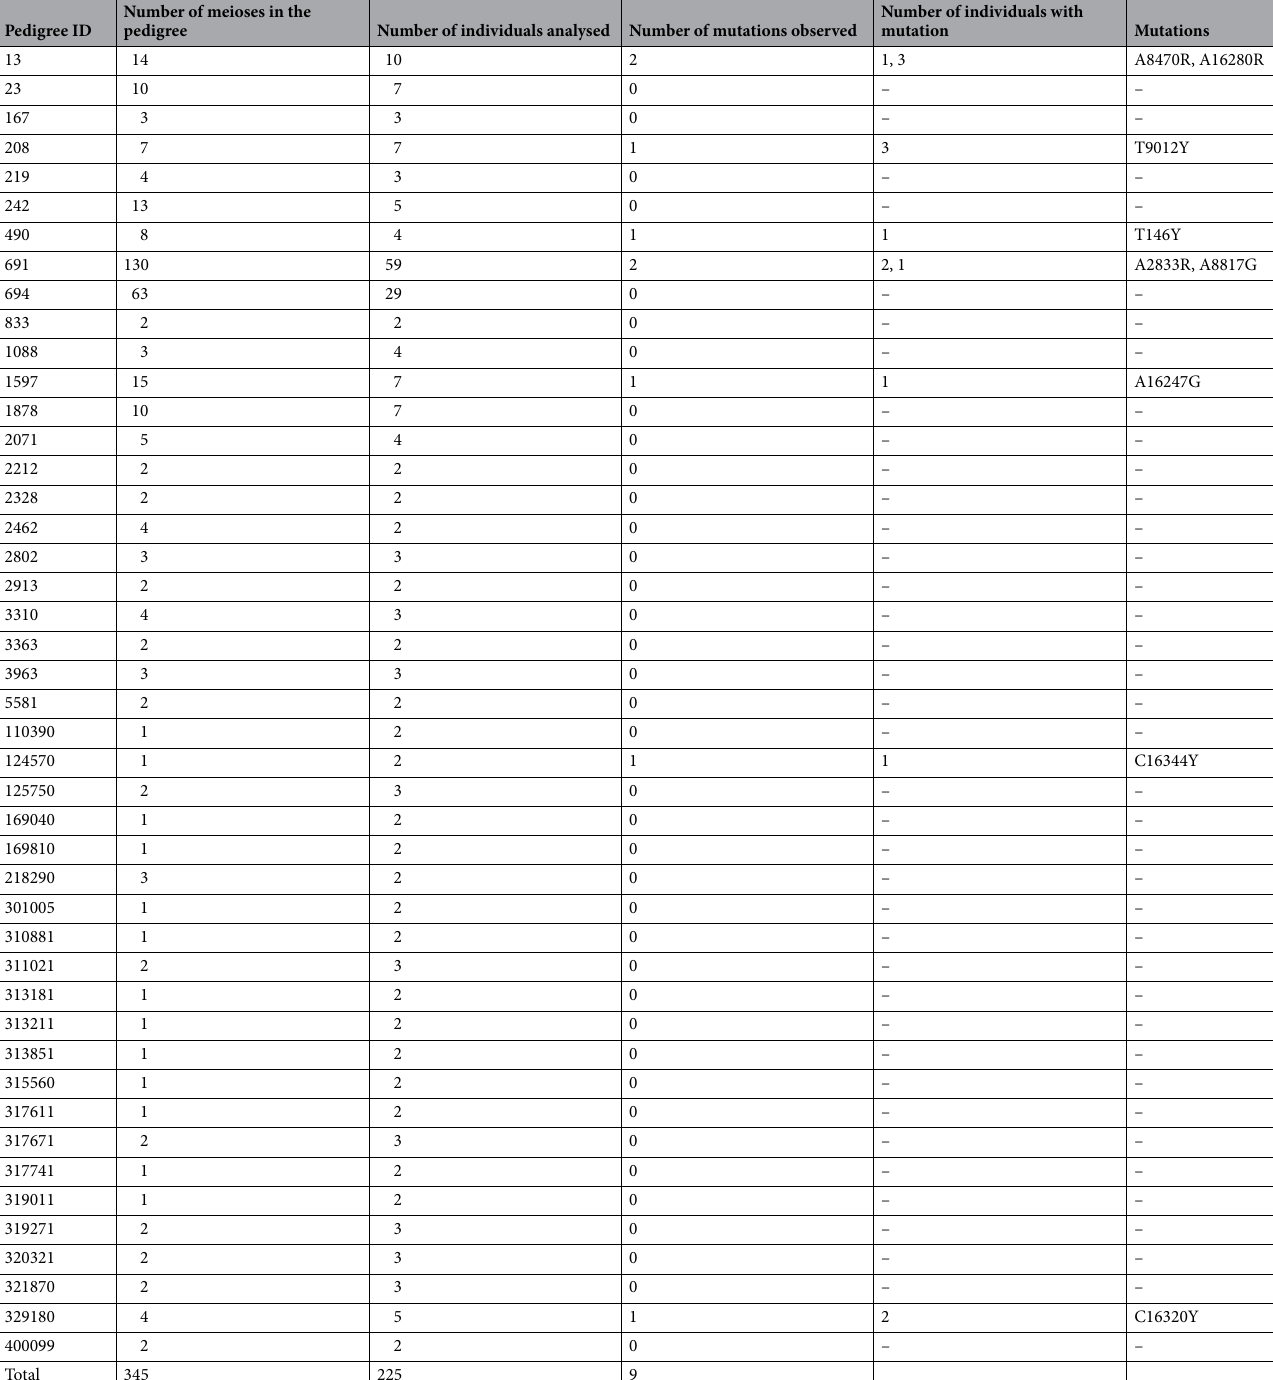
Table 1. Mutations observed in 45 maternal lineages. Heteroplasmy are designated with an International Union of Biochemistry code 27